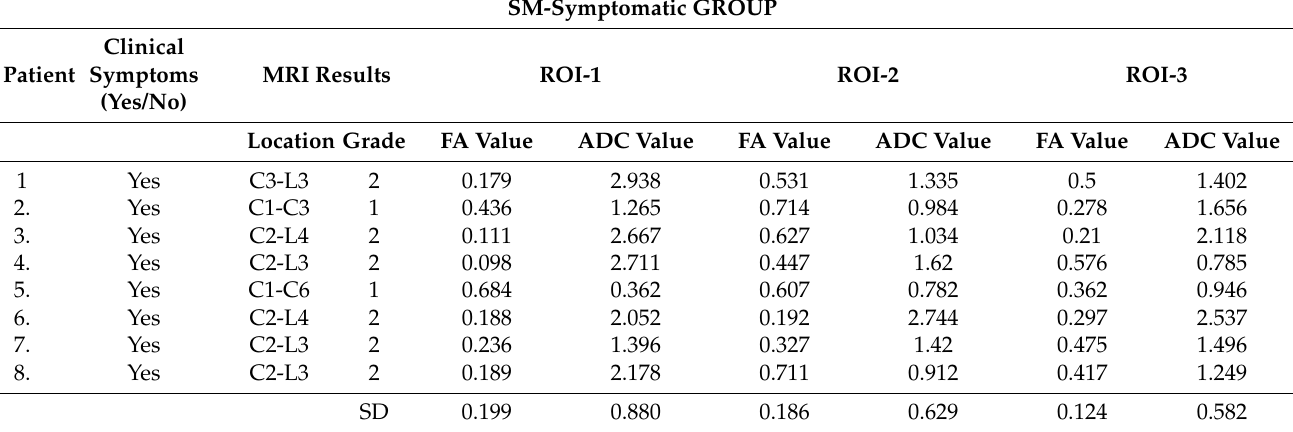
Table 3. Clinical and MRI results of the SM-symptomatic group with FA and ADC measurements from ROI-1, ROI-2 and ROI-3.